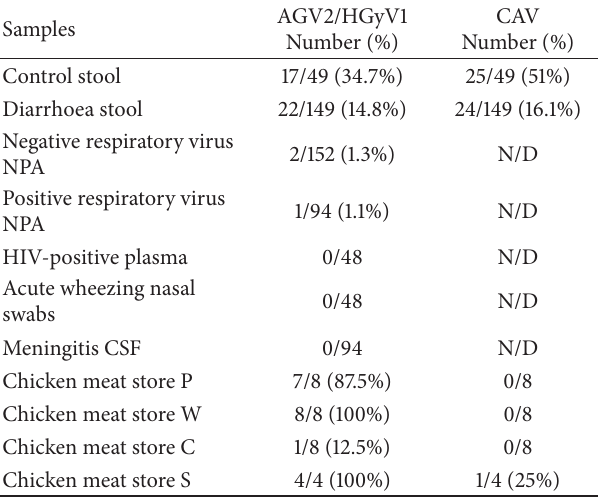
Table 1: PCR screening of clinical and chicken samples for the presence of AGV2/HGyV1 and